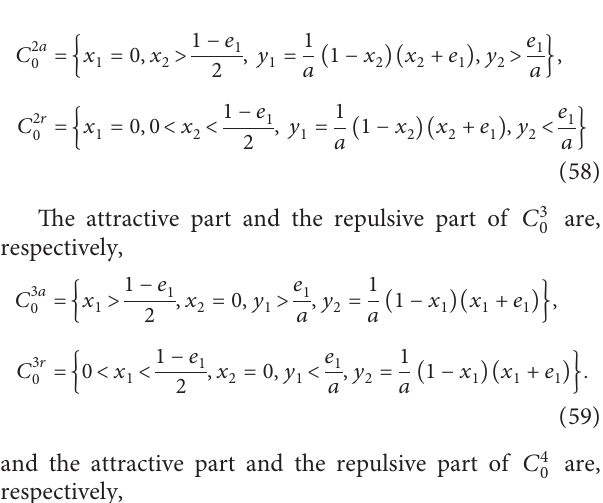
Figure 6: Choose ( τ the equilibrium E Time series with the black dashed curve (prey) and red full curve